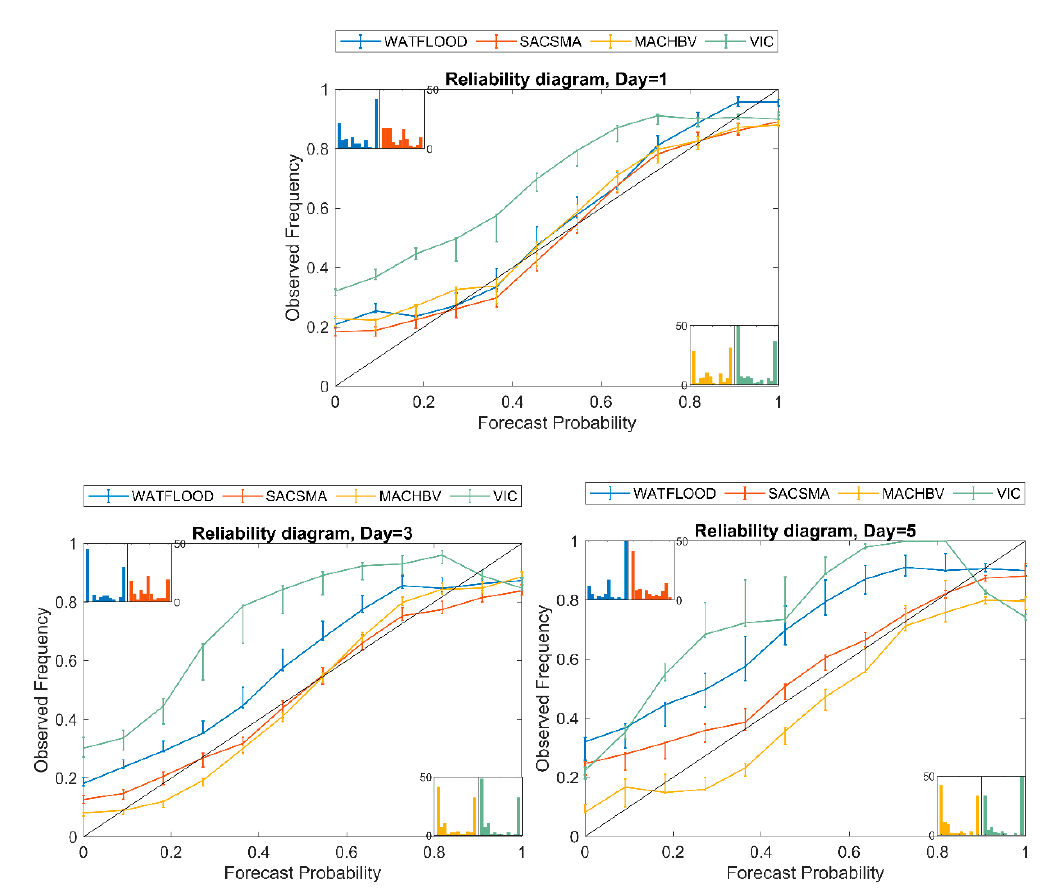
Figure 9. Reliability diagrams of ensemble reservoir inflows at three selected forecast lead times. Different colors show different model types. The 90% confidence intervals were shown in the reliability lines for each model. The inset histograms show the frequency of occurrence in each forecast bin.